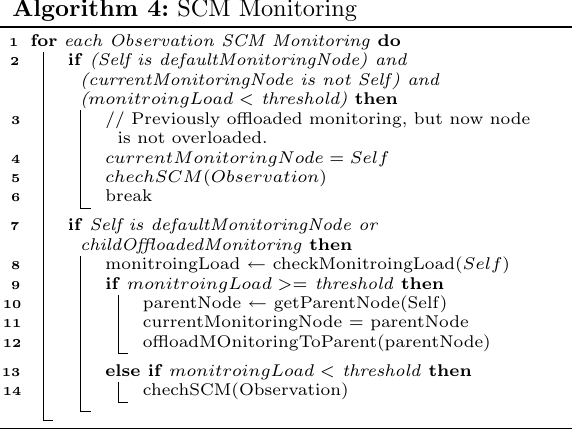
Algorithm 4: SCM Monitoring